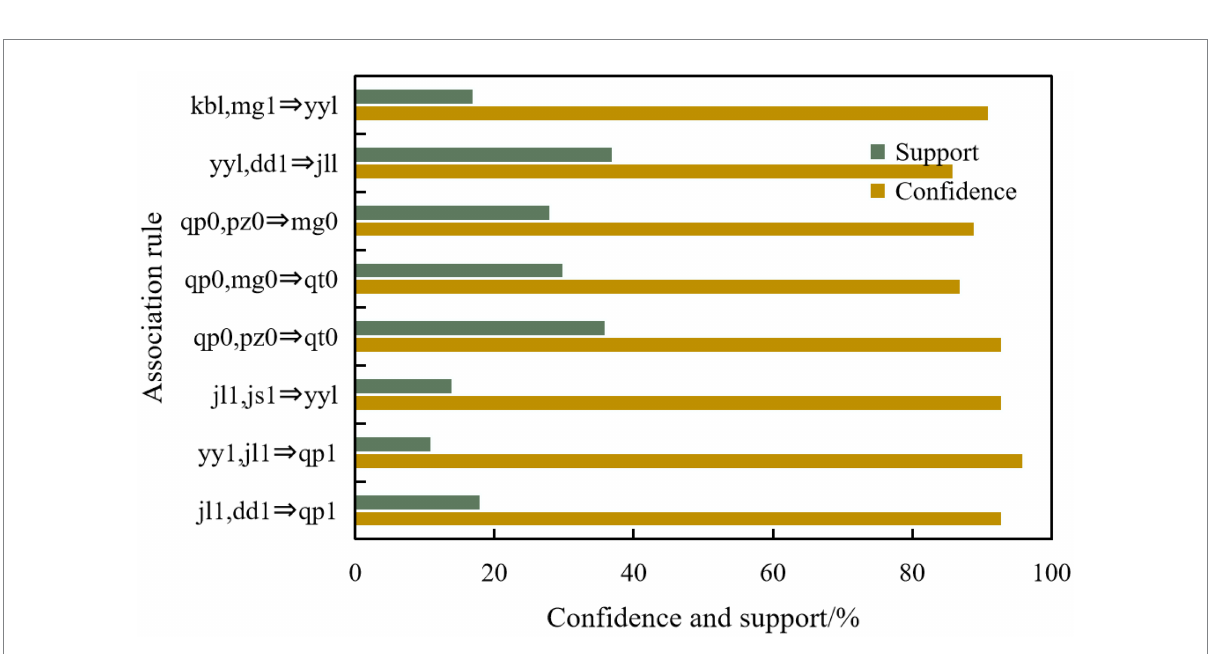
FIGURE 7 Partial association rules between interpersonal sensitive symptoms and basic information.